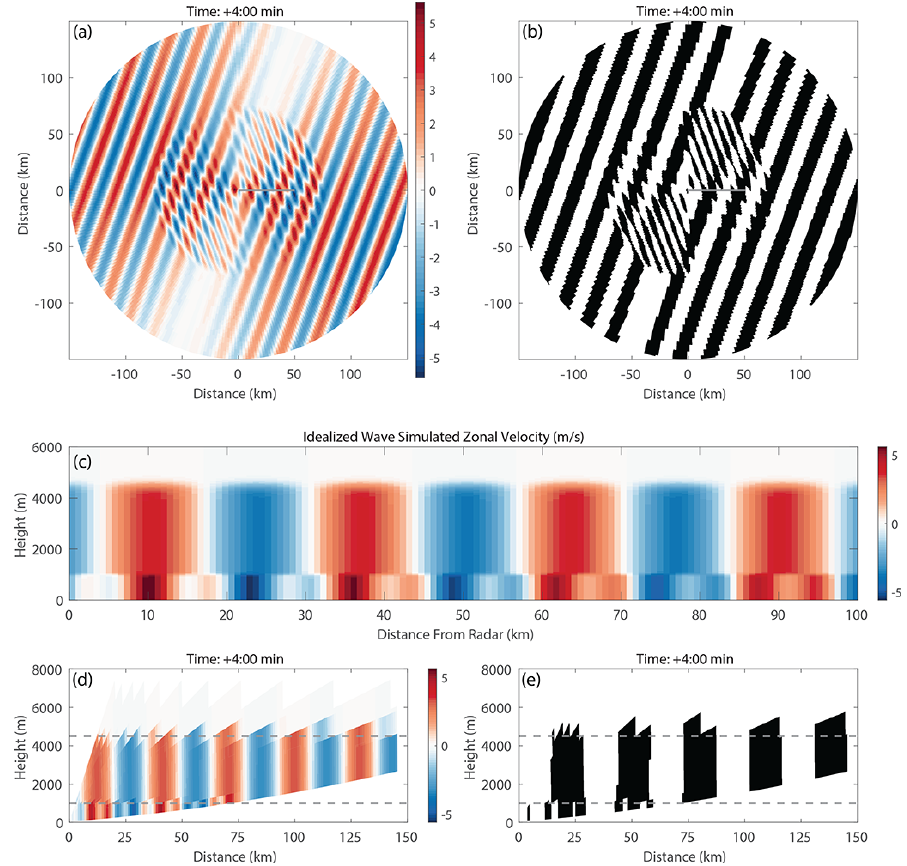
Figure 4. Simulated PPIs, RHIs, and vertical cross sections of two superimposed idealized waves. The longer-wavelength wave has a wavelength of 25km, a depth of 4500m, and a maximum horizontal velocity perturbation of 4ms − 1 and moves toward 290 ◦ with its long axis along 200 ◦ . The shorter-wavelength wave has a wavelength of 8km, a depth of 1000m, and a maximum horizontal velocity perturbation of 2ms − 1 and moves toward 250 ◦ with its long axis along 160 ◦ . Simulated radar has the following characteristics similar to a NWS WSR- 88D radar beamwidth of 0.95 ◦ , 500m range gates, and a maximum range of 150km. (a) Simulated radial velocities for a beam elevation of 0.5 ◦ and (b) the corresponding detected velocity waves. (c) Cross section of the zonal velocity of the prescribed wind field along the solid gray line in the upper panels. (d) Constructed RHI of radial velocity and (e) wave detection from a NWS VCP-12-like scan strategy along the same azimuth (90 ◦ ) as the cross section in (c) . For (d) and (e) elevation angles are 0.5, 0.9, 1.3, 1.8, 2.4, 3.1, 4.0, 5.1, 6.4, 8.0, 10.0, 12.0, 14.0, 16.7, and 19.5 ◦ . The dashed lines denote the tops of the two idealized waves. Panel (c) uses a 1:3.2 z -axis to x -axis aspect ratio, and panels (d) and (e) use a 1:8.4 aspect ratio. An animated version of this figure is in Video Supplement